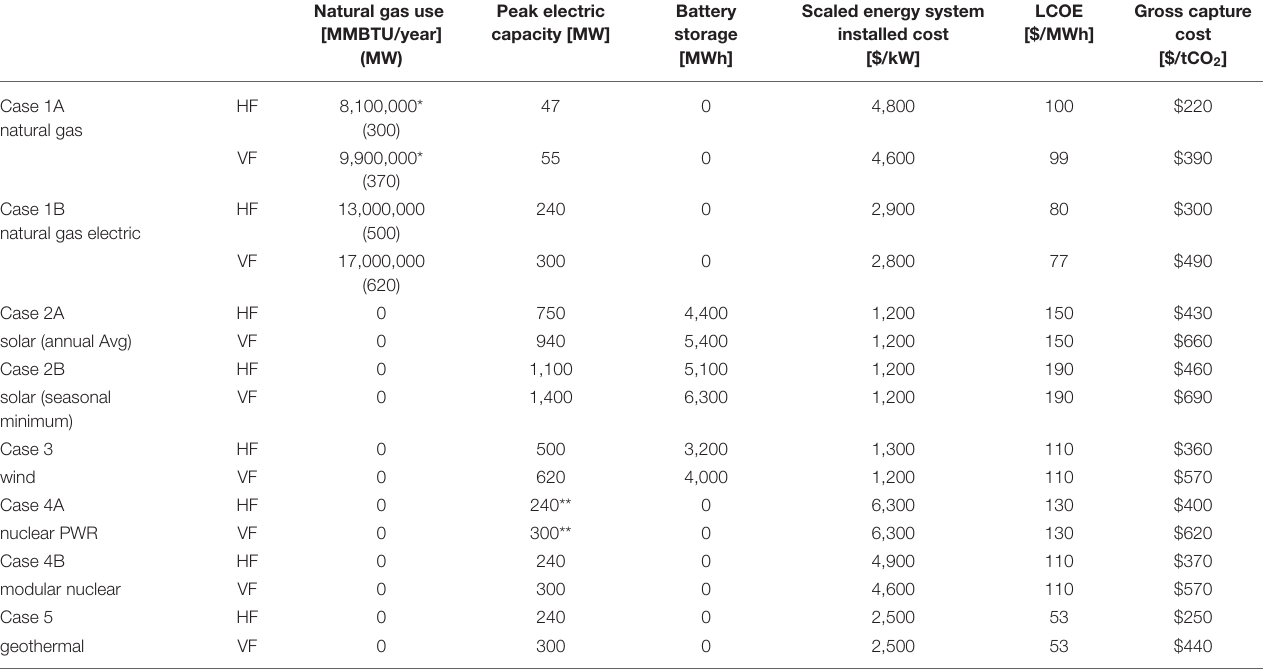
TABLE 5 | Natural gas use, peak electricity, stored electricity capacity, LCOE, and gross capture cost.